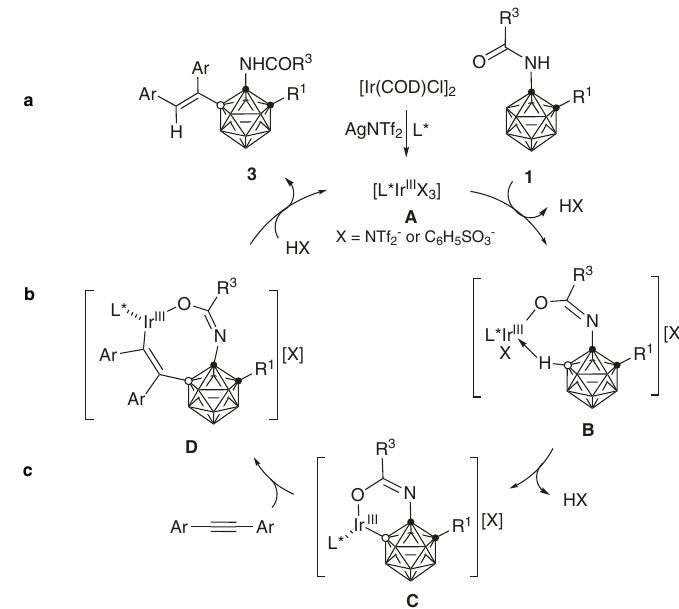
Fig. 7 Proposed catalytic cycle. Possible reaction mechanism of the Ir- catalyzed enantioselective B − H alkenylation. The chiral ligand on Ir has been marked as L* for clarity.